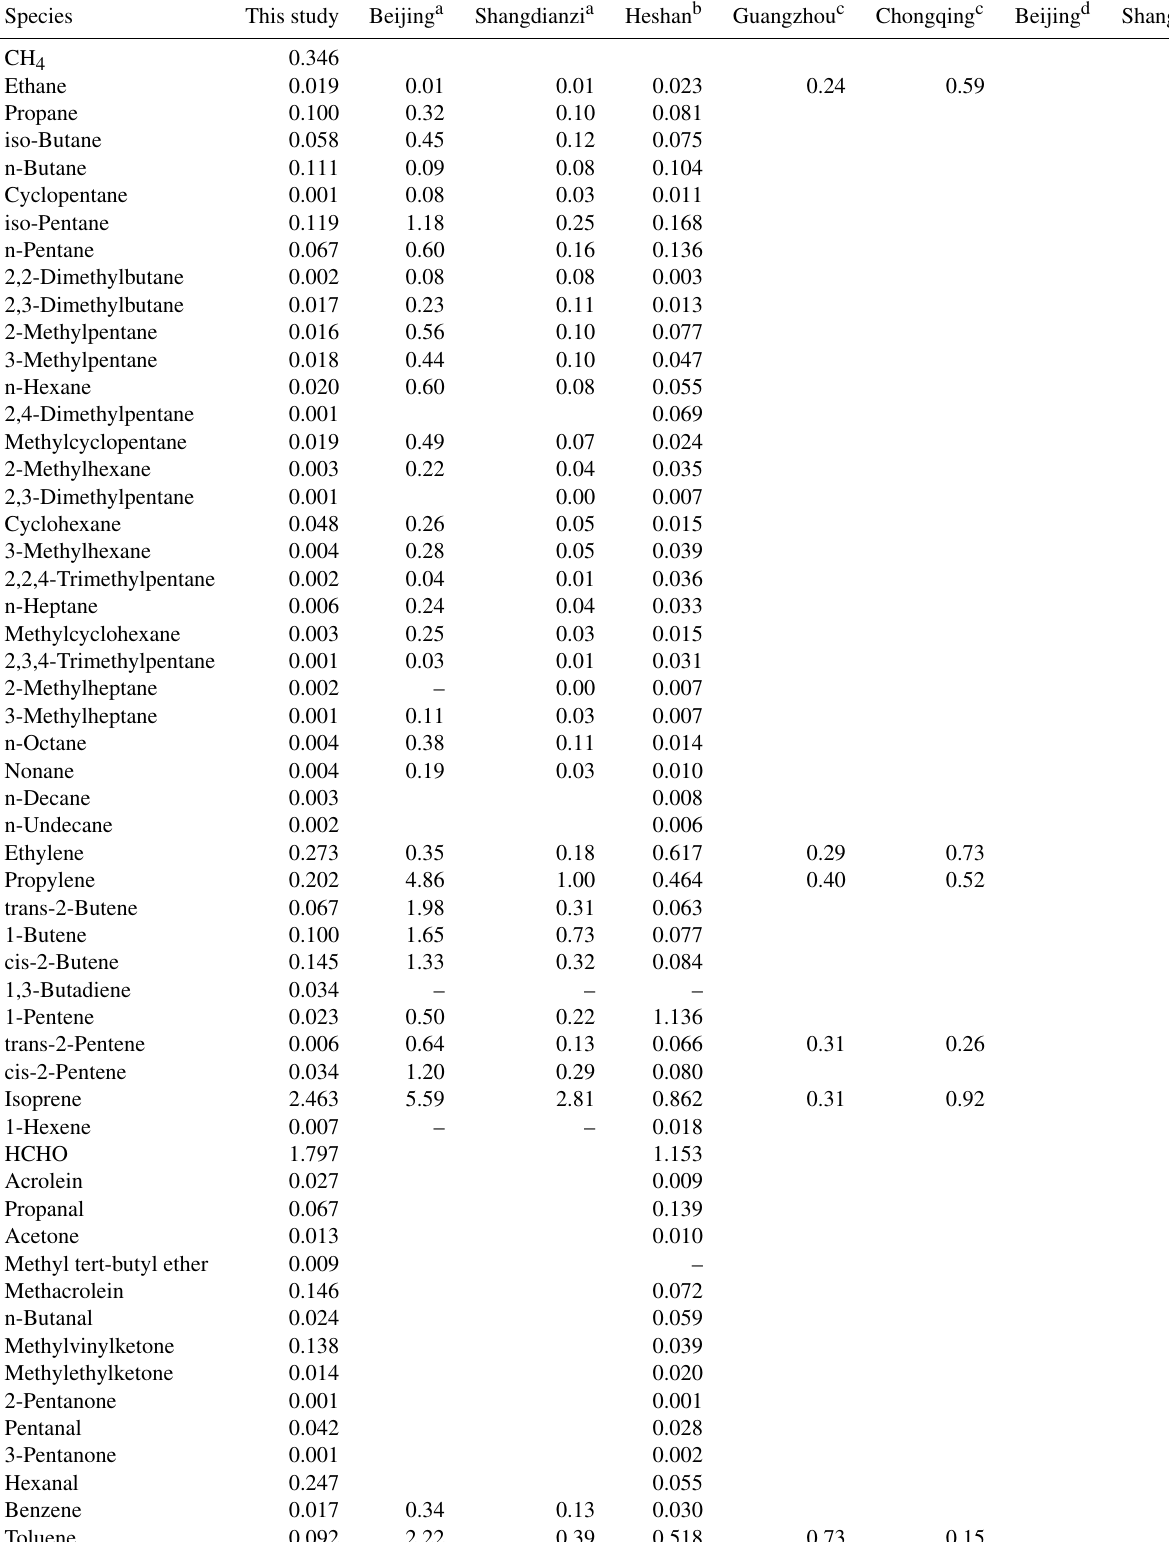
Table 1. Comparison of speciated OH reactivity with former studies in China. Species This